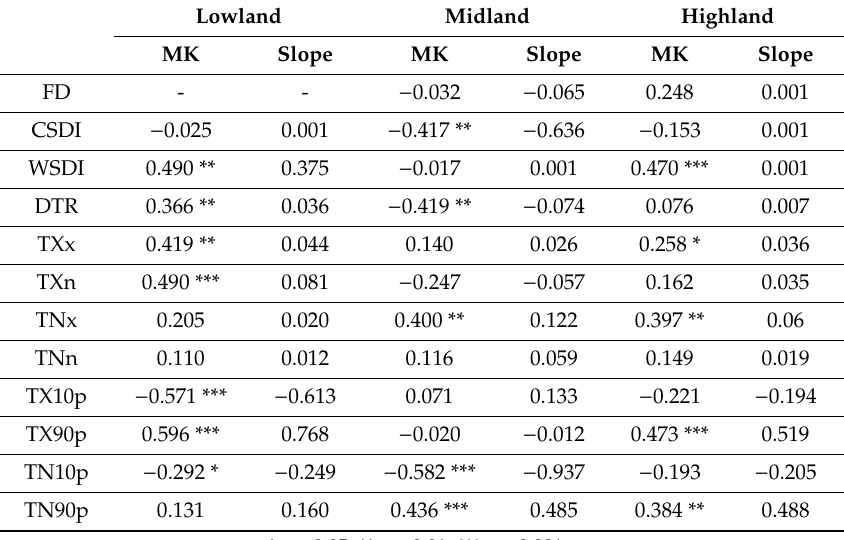
Table 3. Trends of extreme temperature indices by agro-ecological settings (1988–2017).